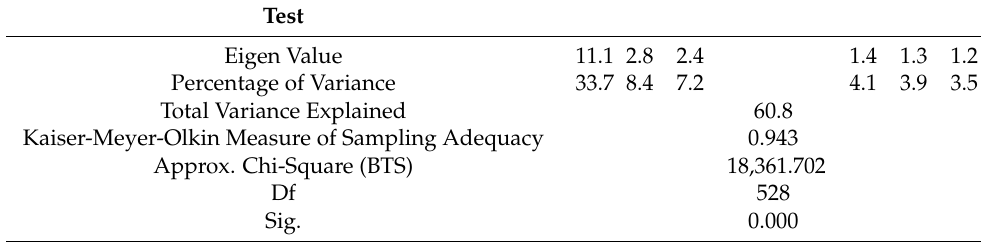
Table 3. Eigen Values, KMO & BTS Tests.